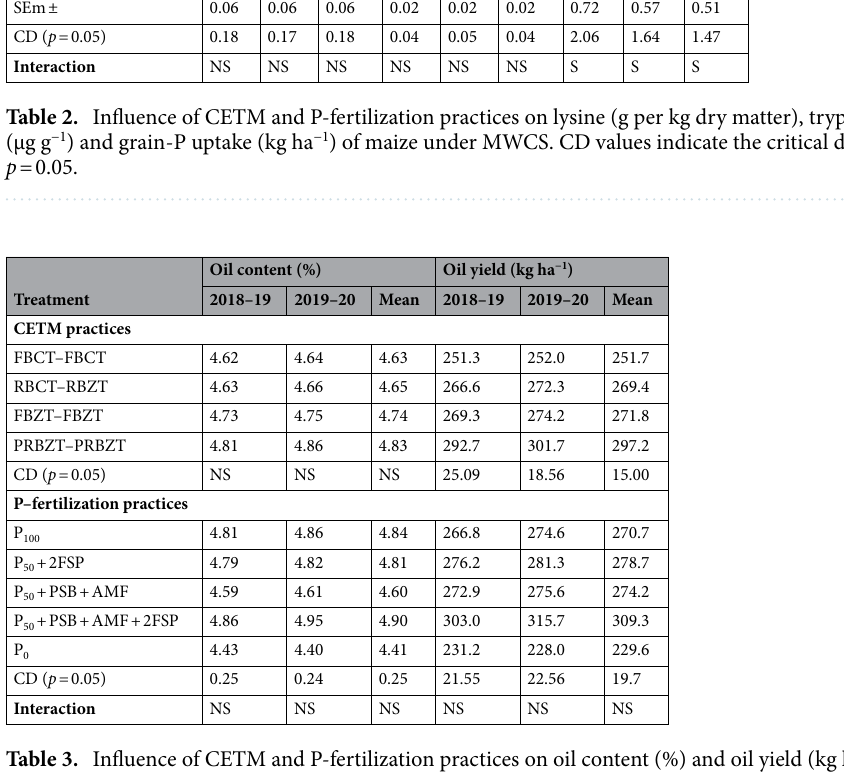
Table 3. Influence of CETM and P-fertilization practices on oil content (%) and oil yield (kg ha −1 ) of maize under MWCS. CD values indicate the critical difference at p =